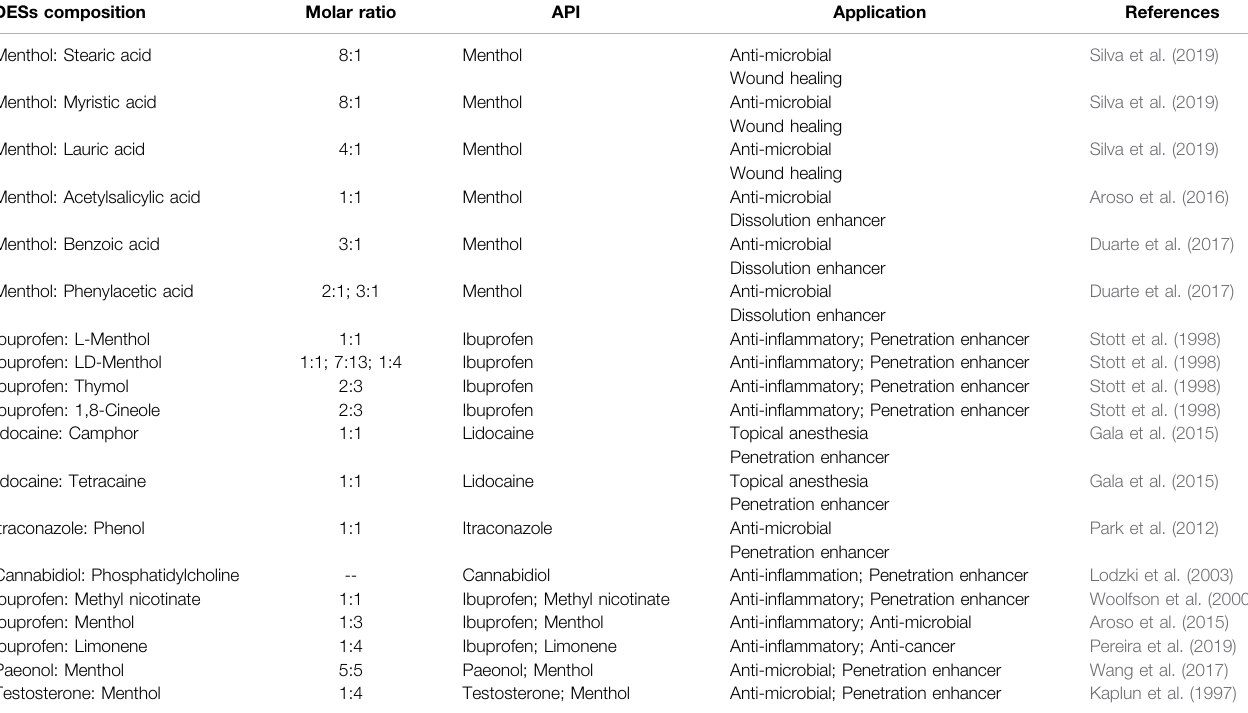
TABLE 1 | The composition, molar ratio and application of API-based DESs. DESs composition Molar ratio